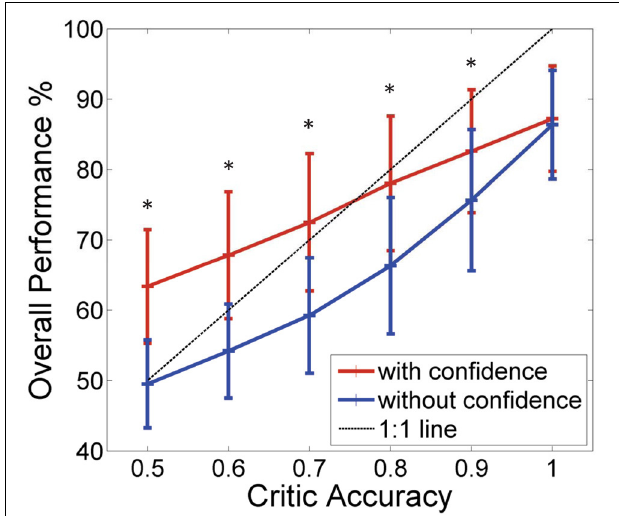
FIGURE 6 | Results of the simulations where the monkey controls the robot arm. Performance of the BMI Vs the critic accuracy with and without confidence inbuilt for data collected from monkey DU. (mean ± standard deviation. One thousand simulations). Red: New update rule with confidence. Blue: Previous method with no confidence. Black: 1:1 relationship. Critic accuracy was varied from 50 to 100% with 100% being the best. ∗ Shows the values which showed statistical significant difference (alpha 0.001). At lower critic accuracies, the new update with confidence performs much higher than the one without the confidence measure. As the critic accuracy increase, the plot with the confidence measure is able to outperform the curve without the confidence measure. However, the difference in the performance becomes smaller as the critic accuracy increases suggesting as before that the critic is no longer the limitation, but the nature of the input data